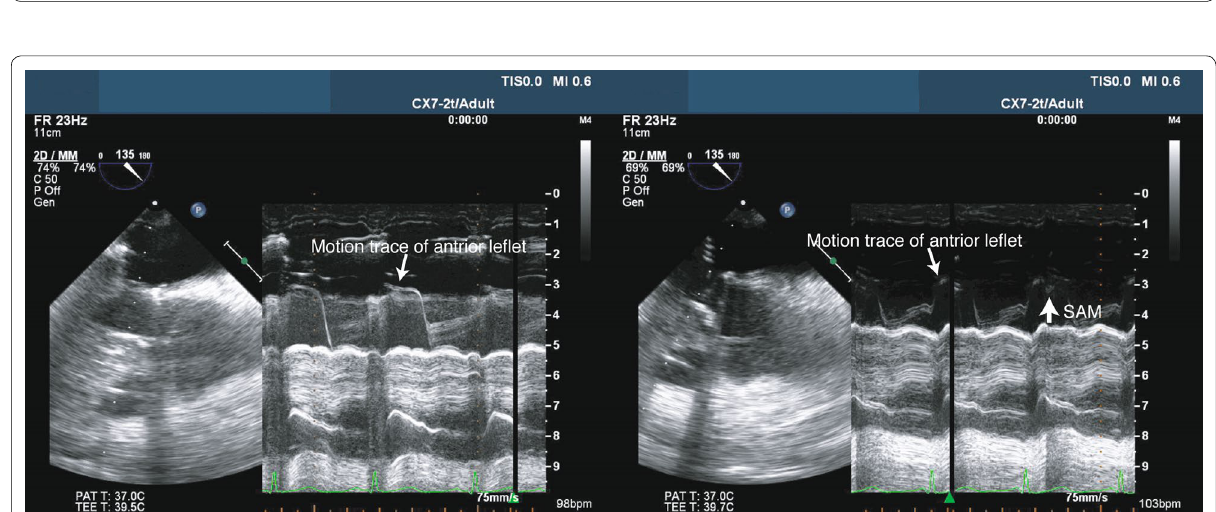
Fig. 3 Motion tracing of the anterior leaflet in normal sinus rhythm (left) and junctional rhythm (right). Systolic anterior motion (SAM) is shown in junctional rhythm (large